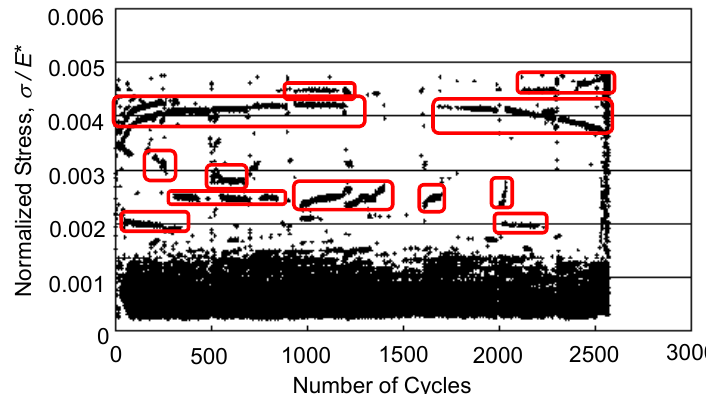
Fig. 6. Distribution of AE events during compressive fatigue test [ σ a / E* = 0.0023].